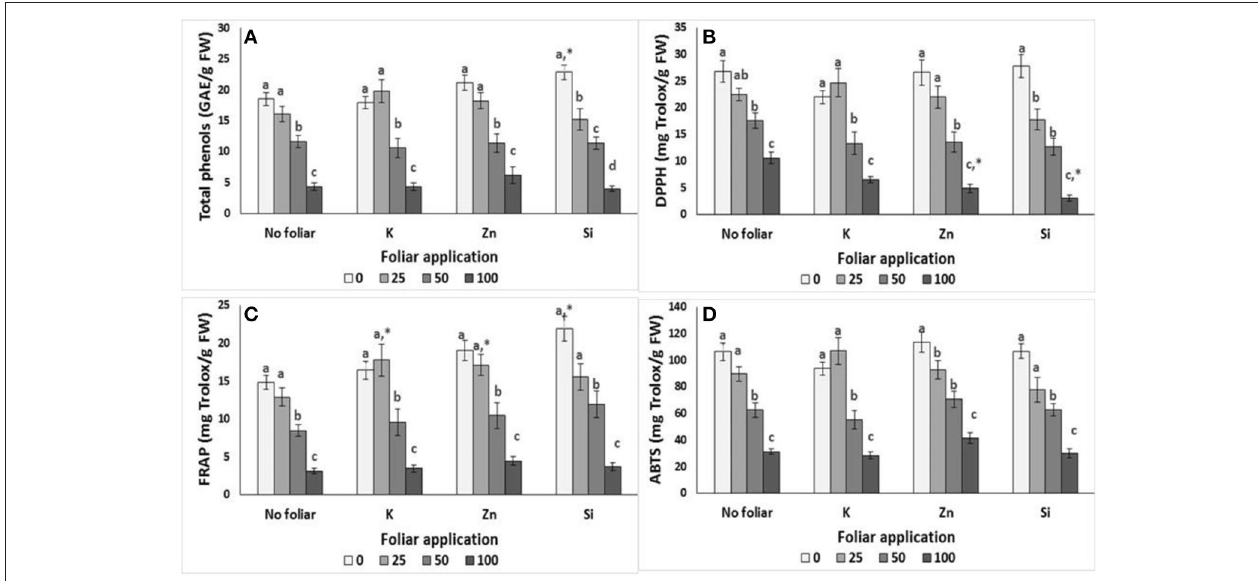
FIGURE 1 | Effect of salinity levels (0–25–50–100mM NaCl) and foliar applications (no foliar, K, Zn, Si) on the content of total phenols and antioxidant activity in lavender. (A) Total phenols, (B) DPPH, (C) FRAP, and (D) ABTS. Significant differences ( P < 0.05) among salinity treatments are indicated by different letters. Star (*) symbol indicated significance differ among no foliar and equivalent cation foliar. Error bars show SE ( n = 6).